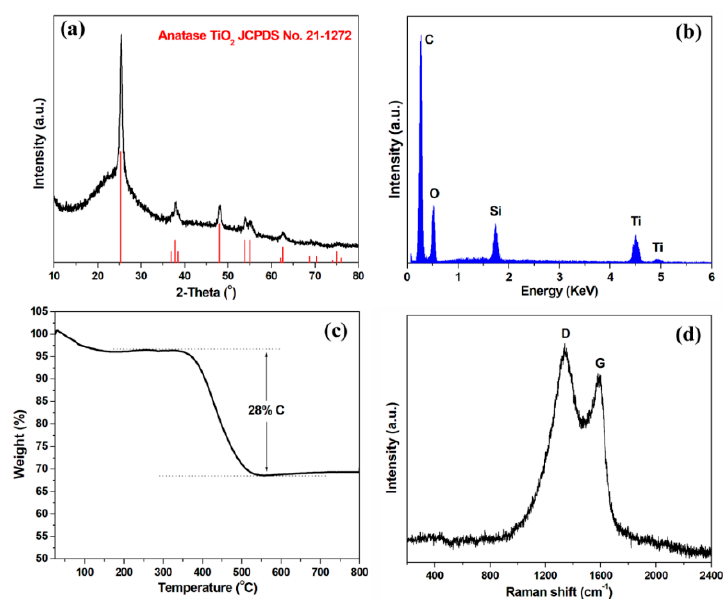
Figure 1. ( a ) XRD pattern, ( b ) EDS spectrum, ( c ) TGA curve and ( d ) Raman spectrum of TSC nanofibers.